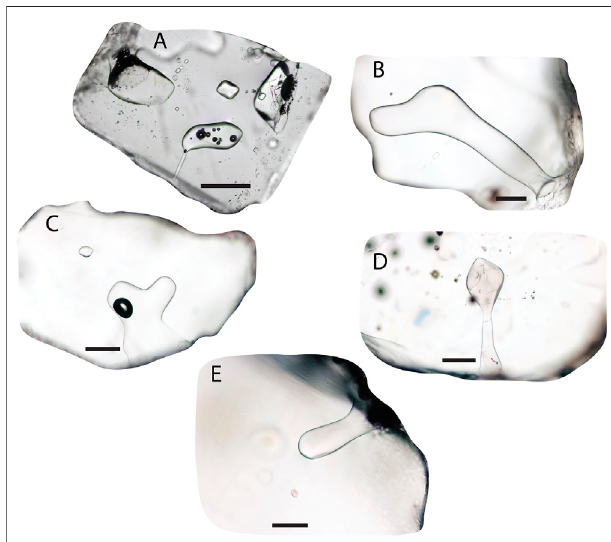
FIGURE 4 | Photomicrographs of embayment morphology classi fi cations; (A) hourglass inclusion from the Bandelier Tuff (with discrete bubbles); (B) a bent embayment within the Kos Plateau Tuff; (C) complex embayment from the Kos Plateau Tuff (with a discrete bubble); (D) bulbous embayment in the Huckleberry Ridge Tuff; and (E) simple embayment from the Mesa Falls Tuff. Scale bar in each panel is 200 µm.